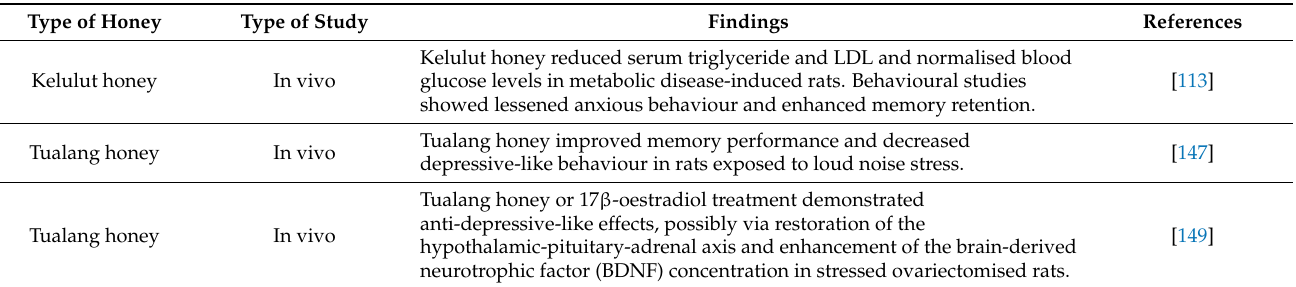
Table 12. Summary of the effect on nervous